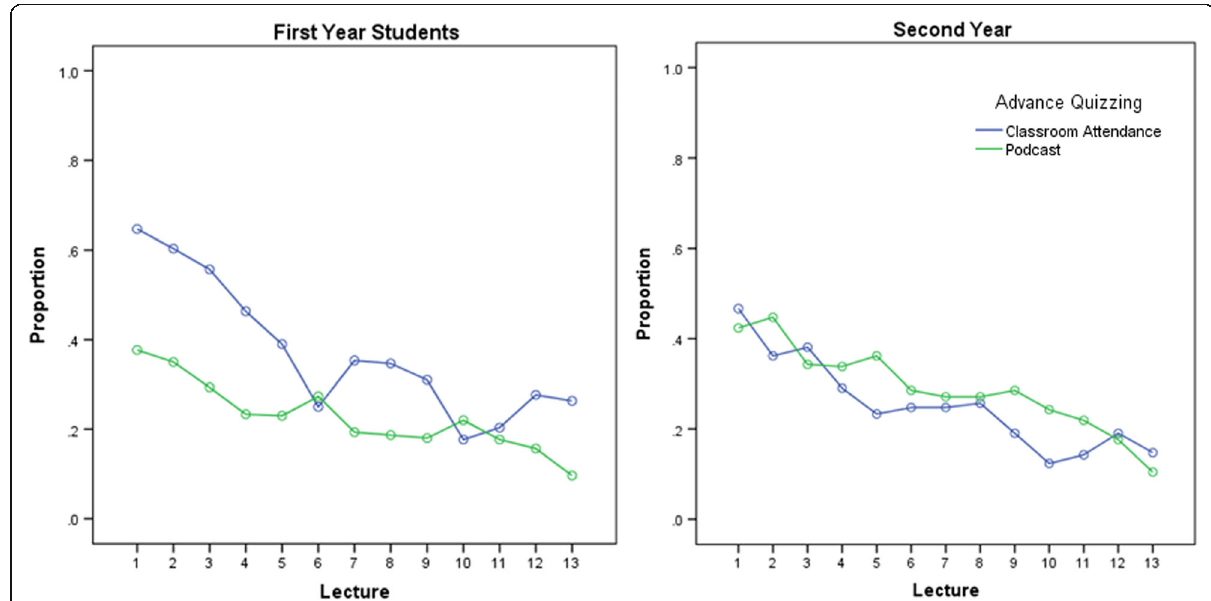
Fig. 1 Use of advance quizzing during class (classroom attendance) or after class (podcast) across lectures and separate for first-year and second-year